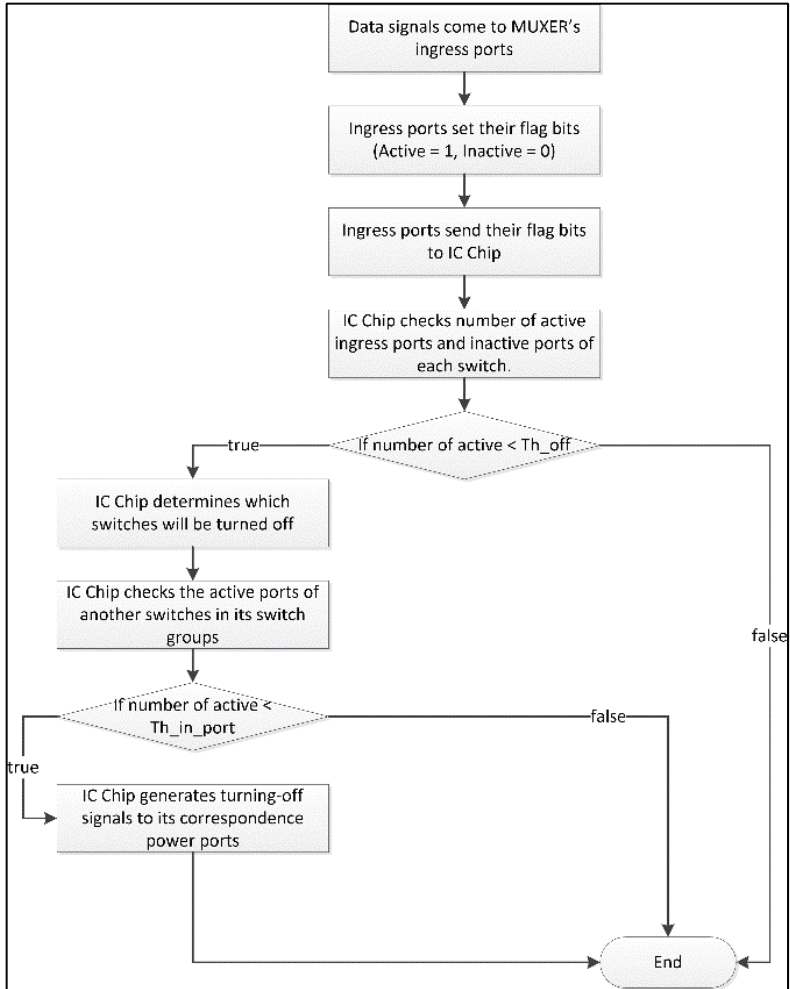
Figure 6. Mechanism of MUXER to turn off and turn on switch.